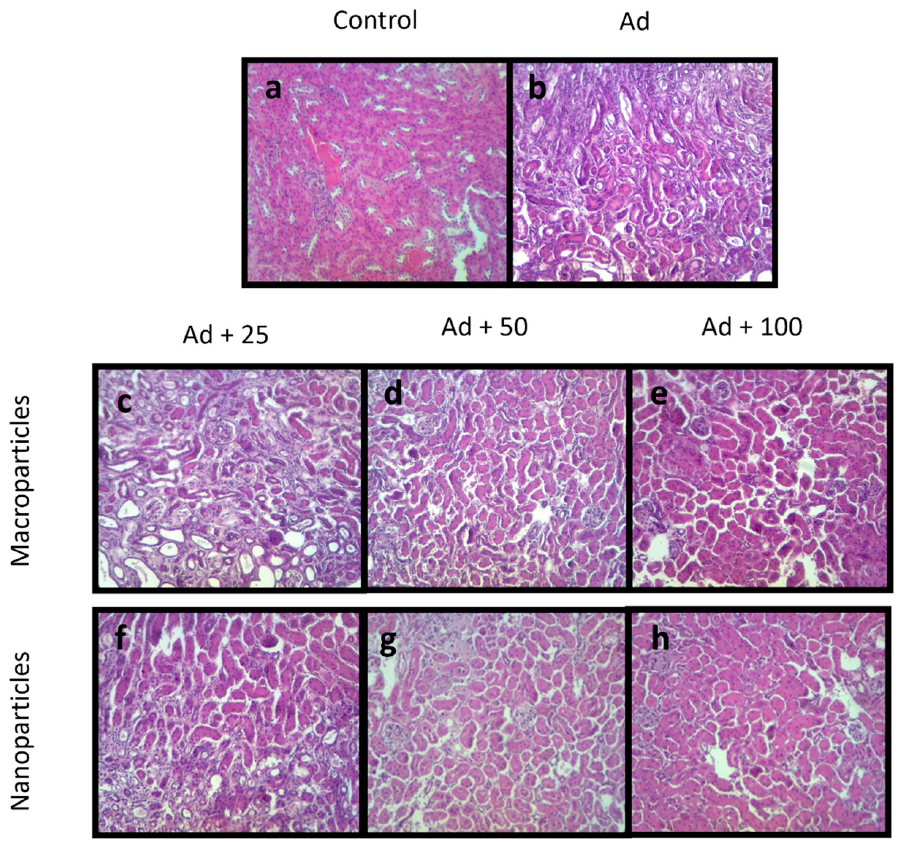
Figure 5. Histopathology analysis of kidney tissue. Kidney samples stained with hematoxylin- eosin were used to analyze inflammation and necrosis. Control kidney samples show normal morphology ( a ), and severe inflammation and necrosis in kidney tissue were observed in adenine-intoxicated animals ( b ). Quercetin treatment prevented the tissue damage induced by adenine where QNPs ( f – h ) showed better effect than QMPs ( c – e ). ( a ): Control, ( b ): Ad, ( c ): Ad + QMP25, ( d ): Ad + QMP50, ( e ): Ad + QMP100, ( f ): Ad + QNP25, ( g ): Ad + QNP50, ( h ): Ad + QNP100. Magnification of 200 ×